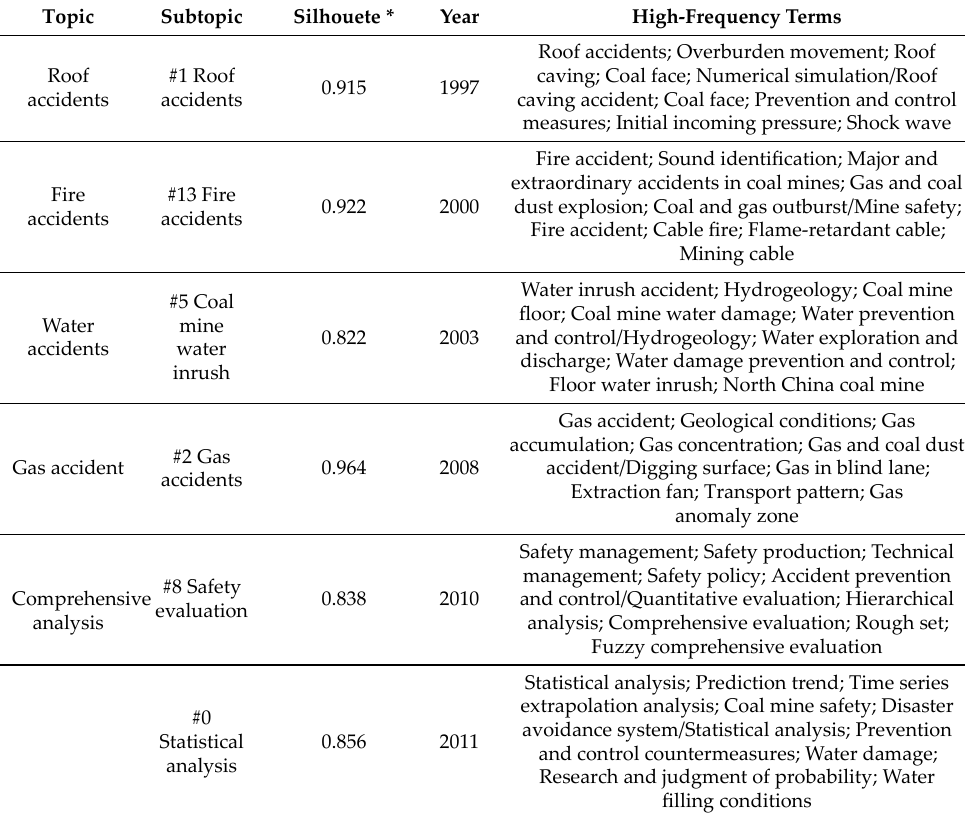
Table 1. Topic and top term of accident characteristics